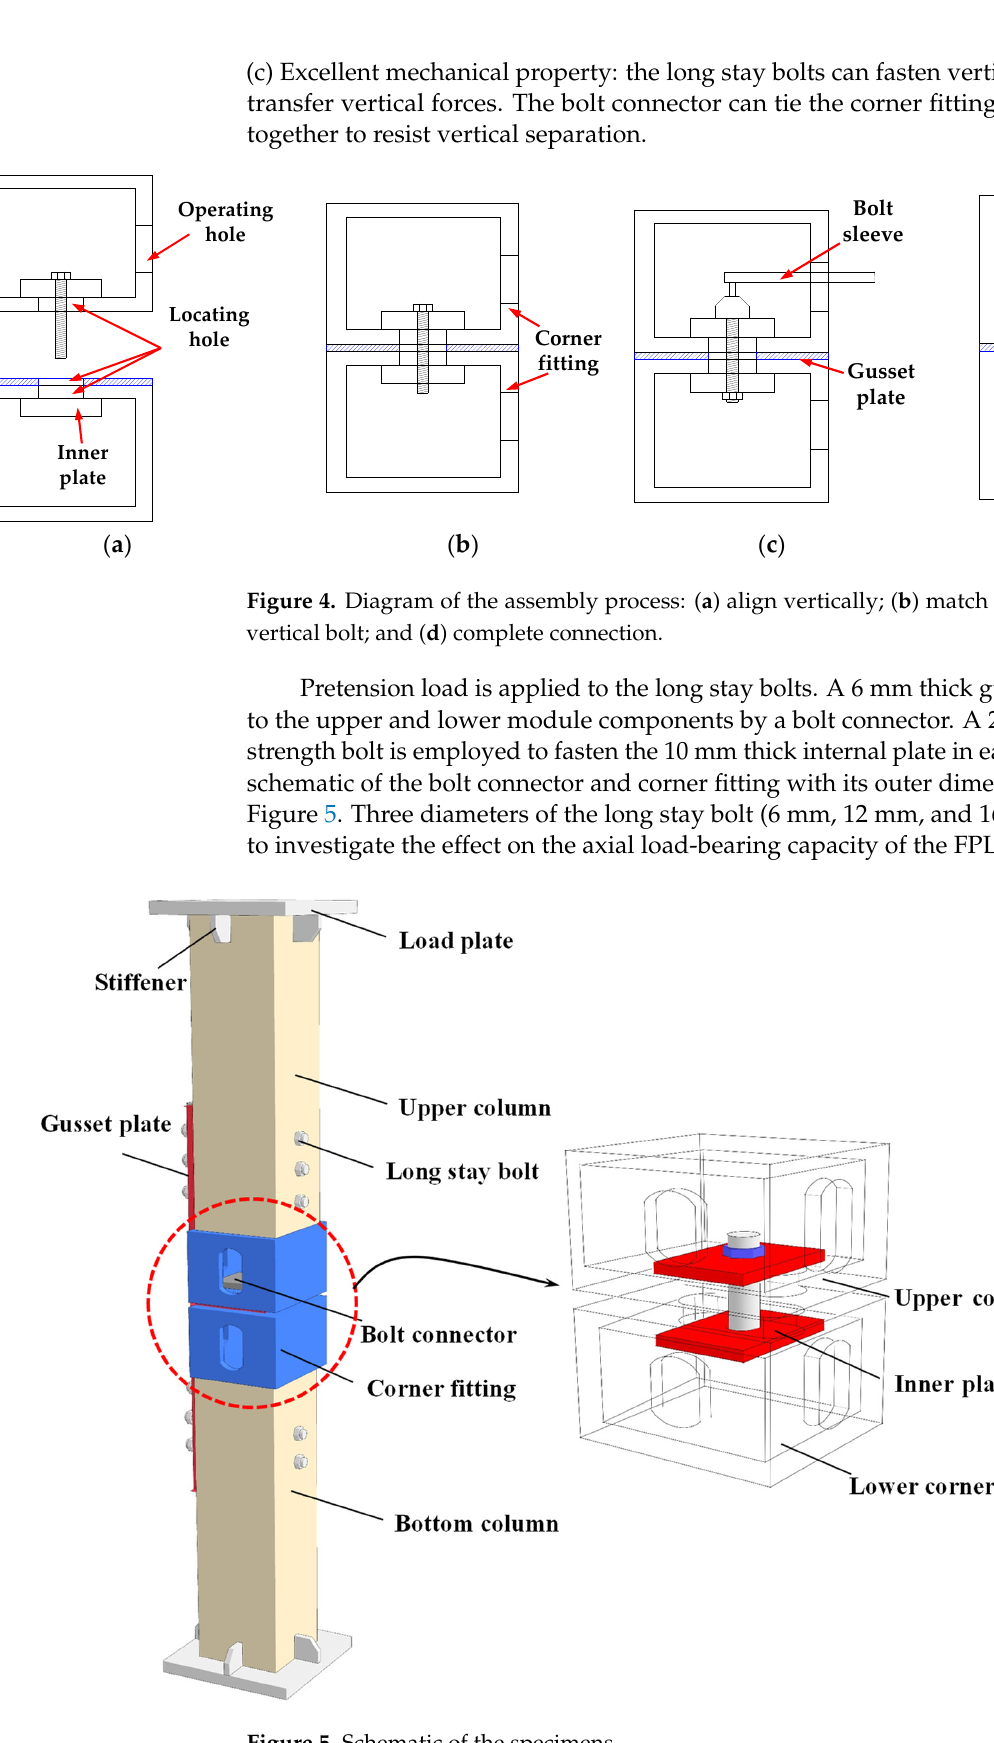
Figure 5. Schematic of the specimens.